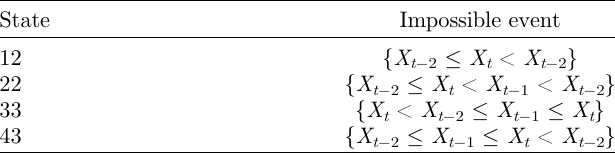
Table 5. Impossible states, coding Z i,t – see equation (4).